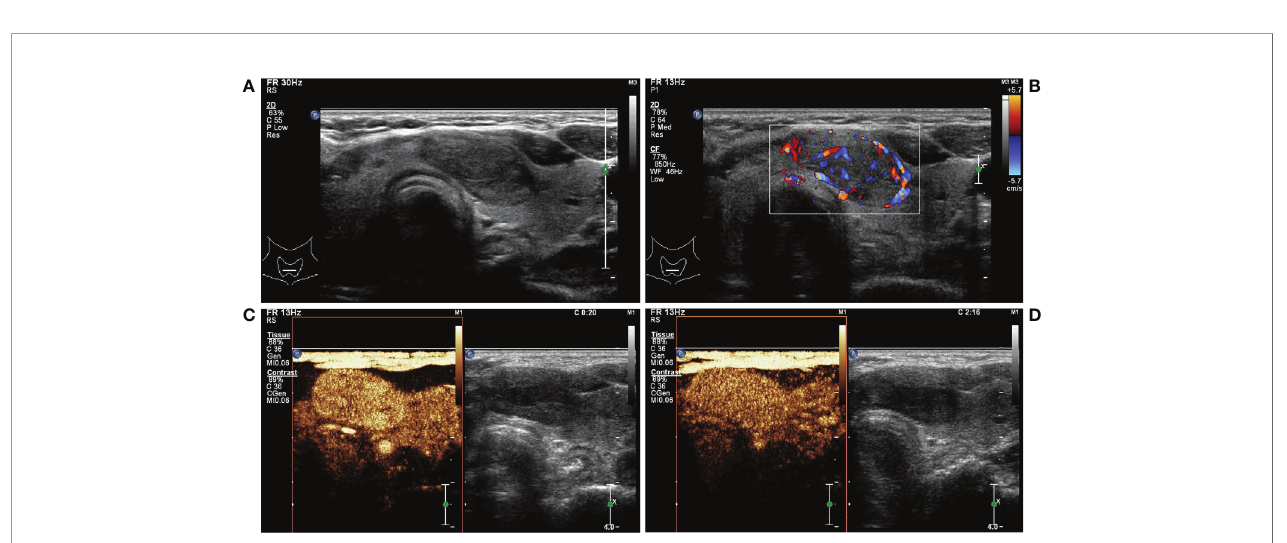
FIGURE 3 | A follicular adenoma in a 63-year-old woman. (A) Greyscale ultrasound showed that there was a solid hypoechoic nodule in the isthmus of the thyroid, with regular margin, wider-than-tall shape, without calci fi cation. The nodule was ACR TI-RADS category 4. (B) Color Doppler showed intranodular and peripheral vascularity. (C) Contrast-enhanced ultrasound revealed hyper-enhancement at peak (the 20th second after the injection of contrast agent), with regular hyper- enhanced ring and well-de fi ned enhanced border. (D) Contrast-enhanced ultrasound revealed hyper-enhancement at the 136th second after the injection of contrast agent, which indicates later wash-out than the surrounding thyroid